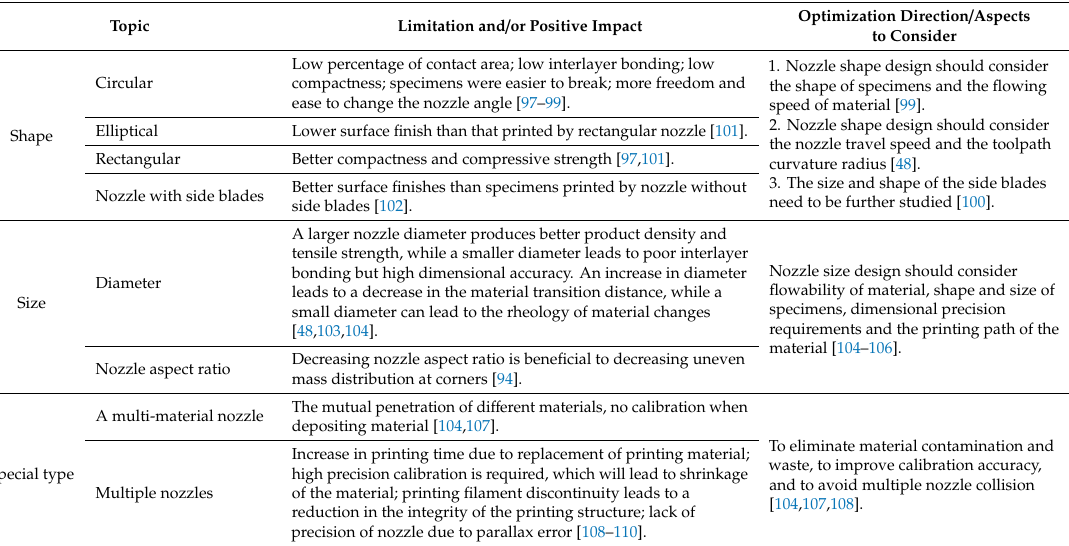
Table 10. Summary of the shape and size of the nozzle.